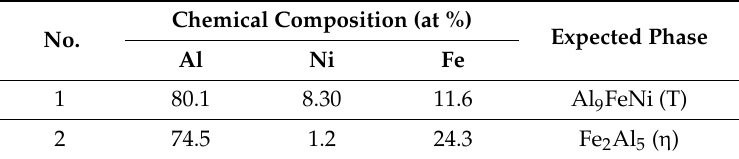
Table 2. EDS microanalysis results of the phases denoted as A and B in Figure 2a.